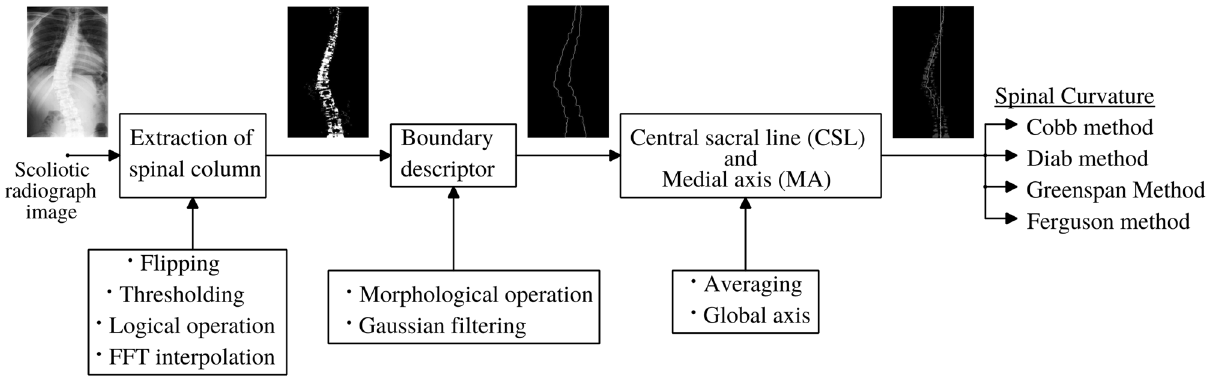
Figure 3. Spinal curvature